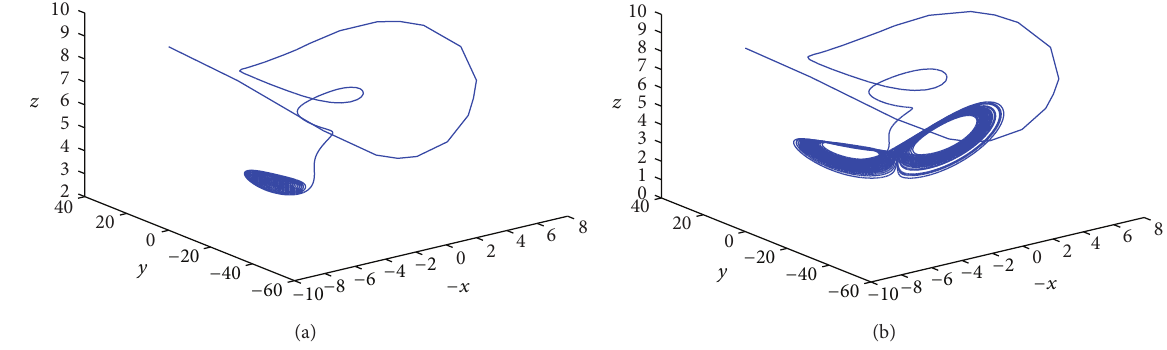
Figure 4: The phase portraits of 𝑥 - 𝑦 - 𝑧 for fractional Lorenz systems 𝛼 = 𝛽 = 𝛾 = 0.91 (left) and 𝛼 = 𝛽 = 𝛾 = 0.92 (right) for the case 𝑟 = 3 .